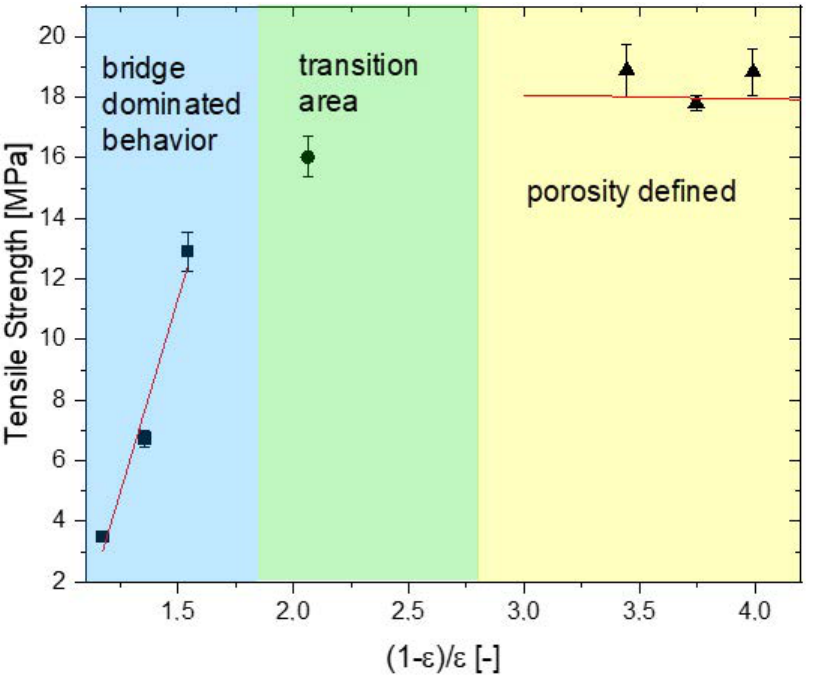
Figure 11. Tensile strength as a function of the quotient 1- (cid:15) and (cid:15) . Three regions can be identified: a linear correlation for BL up to 15% (bridge dominated behavior), a transition area, and porosity defined